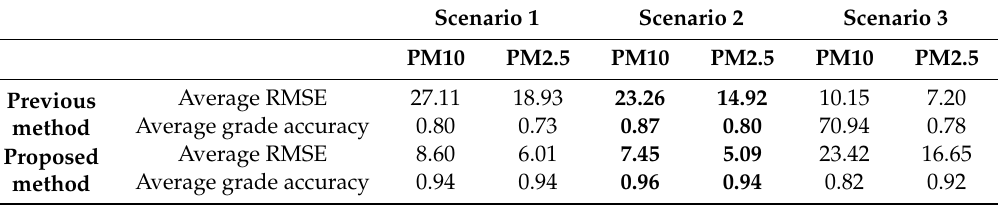
Table 5. Prediction results of three scenarios.